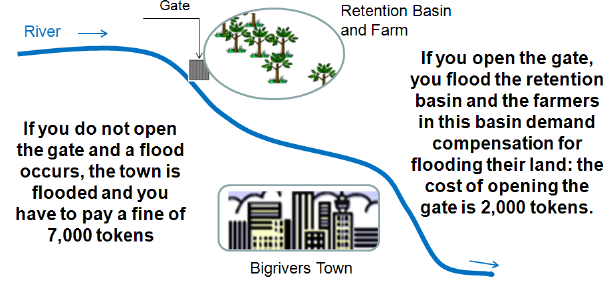
Fig. 1. Schematic of the game as presented to participants. Figure 1. Schematic of the game as presented to participants. 3 4